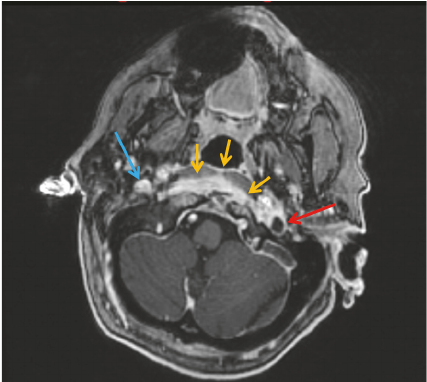
Figure 3: Postcontrast axial FSPGR sequence demonstrating filling defect within the left sigmoid sinus and proximal jugular vein (red arrows). Compare with the normal appearing right jugular vein (blue arrow). Also seen is inflammatory soft tissue in the prevertebral space (orange arrows) which extends into the epidural space behind the dens.